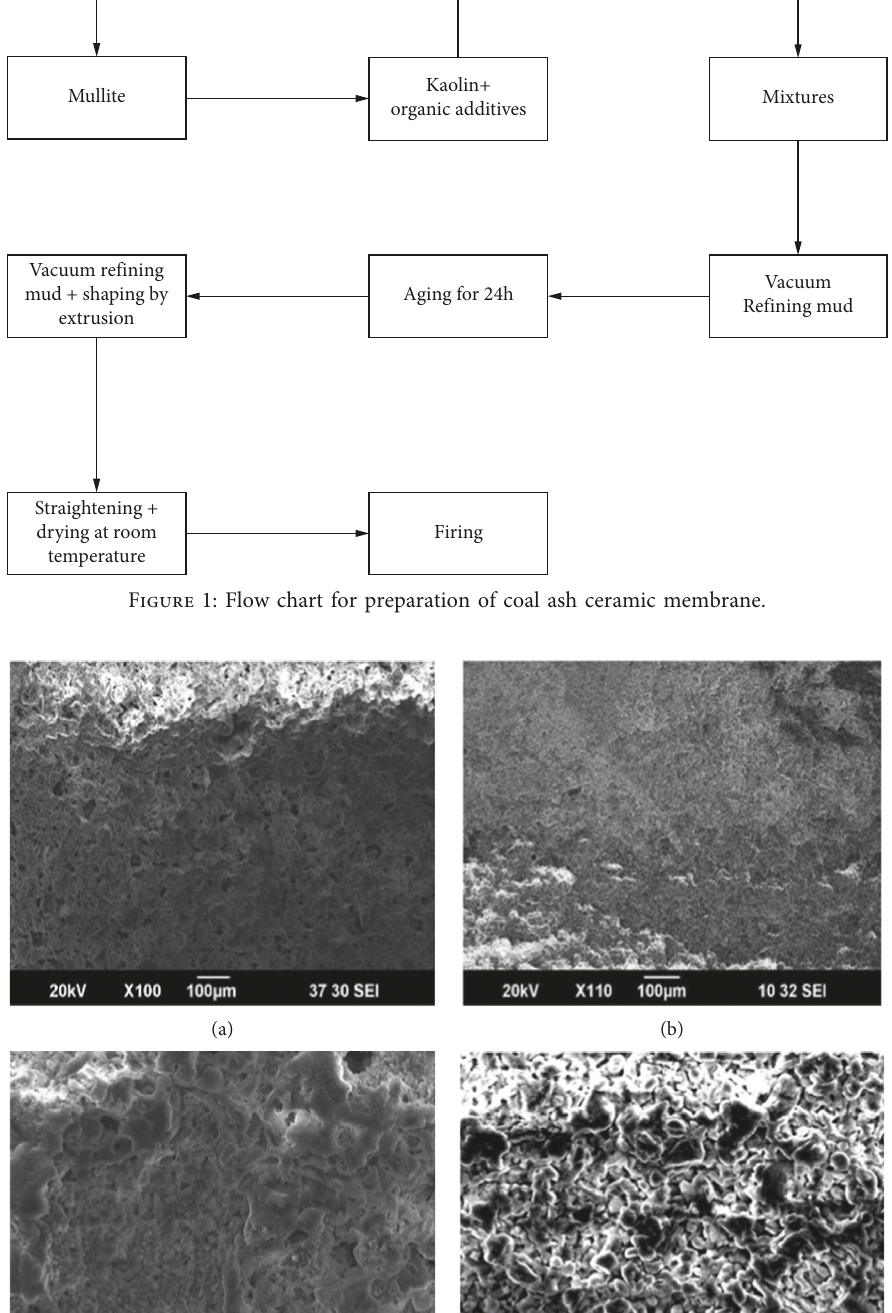
2 O 3 microceramic membrane (size scale:100 μ m); (b) coal ash